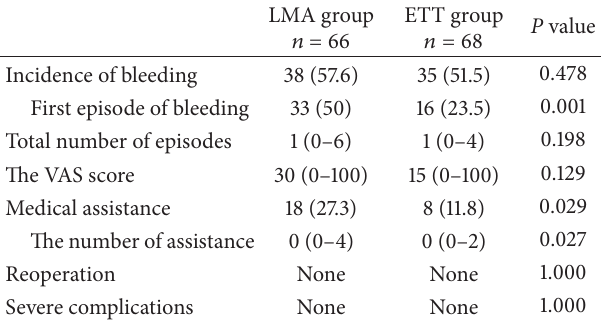
Table 3: Nasal bleeding conditions outside the operation